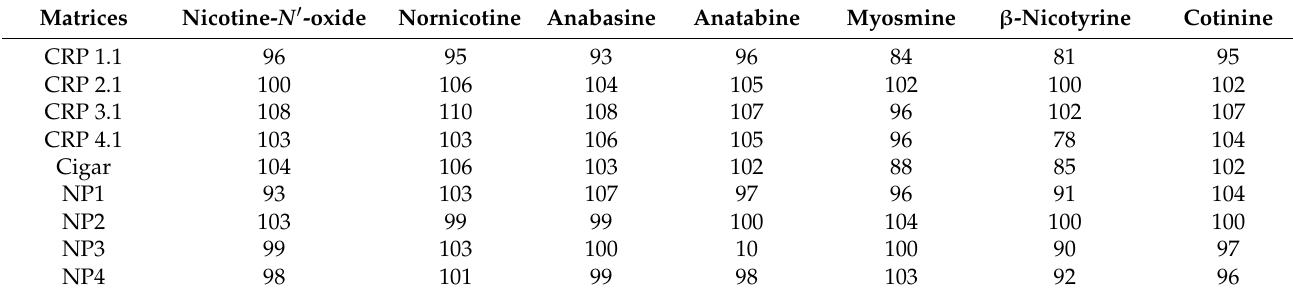
Table 8. Extraction yields (%) for all